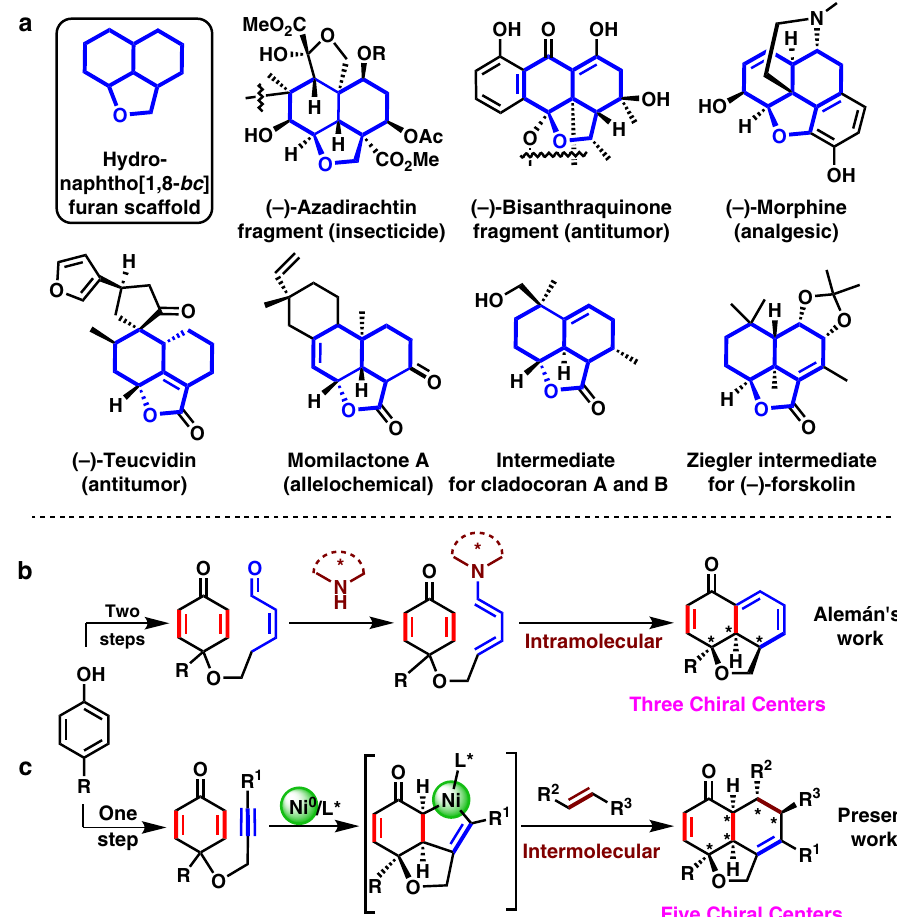
Fig. 1 Hydronaphtho[1,8- bc ]furans and their syntheses from phenols. a Representative examples of biologically active compounds. b Previous work employed desymmetrization by intramolecular [4+2] cycloaddition, catalyzed by organocatalyst. c Present work employed desymmetrization by oxidative cyclization and following intermolecular formal [4+2] cycloaddition process with